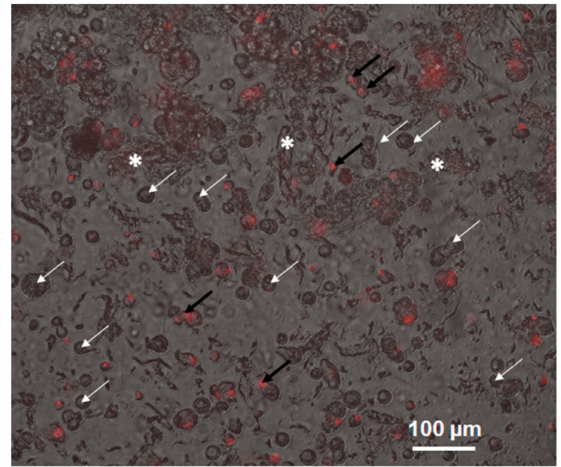
Figure 6. Image in bright field superposed to the corresponding images in red acquired using inverted microscopy of the cell MDA-MB231 cultured in the 3D sca ff old (20 × magnification). White arrows indicate alive and black arrows dead cells whereas white stars the extracellular matrix deposed by cells. Vitality is 78%.